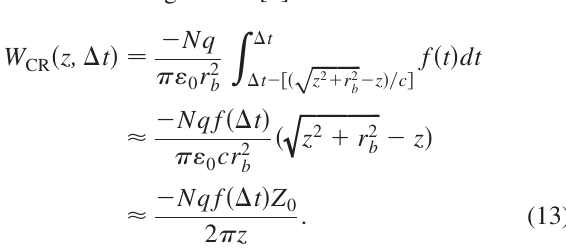
The approximate expressions in Eq. (13) apply for r b (cid:1) (cid:3) =(cid:1) . For drift length L z